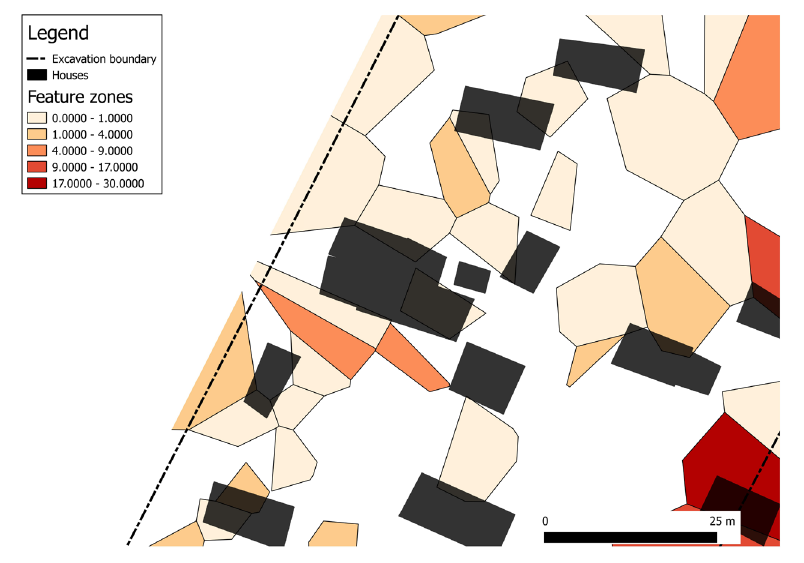
Figure 14: Part of the spatial distribution of the cores made on Type 2 limnosilicite. Note the accumulation of the finds south of the building complex in the